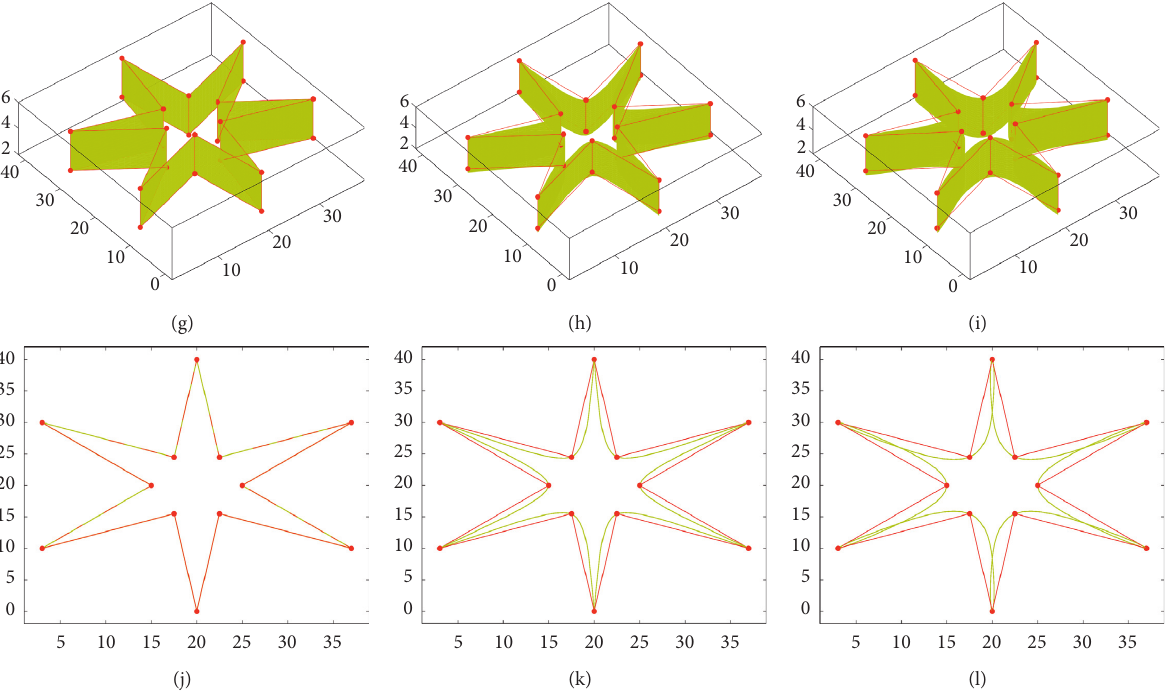
Figure 9: (a–c, g–i) The surfaces generated by the tensor product schemes of Deslauriers and Dubuc [1]. (d–f) The mirror images of the parts inside the blue rectangles of (a–c), respectively. (j–l) The 2-dimensional images in xy -planes of (g–i),